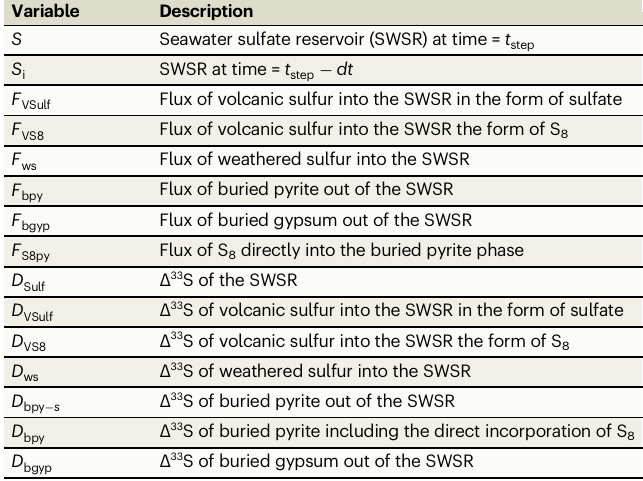
Table 2 | Description of variables used in Eqs. 4 – 9 Table 1 | Description of data and metadata included in multi-